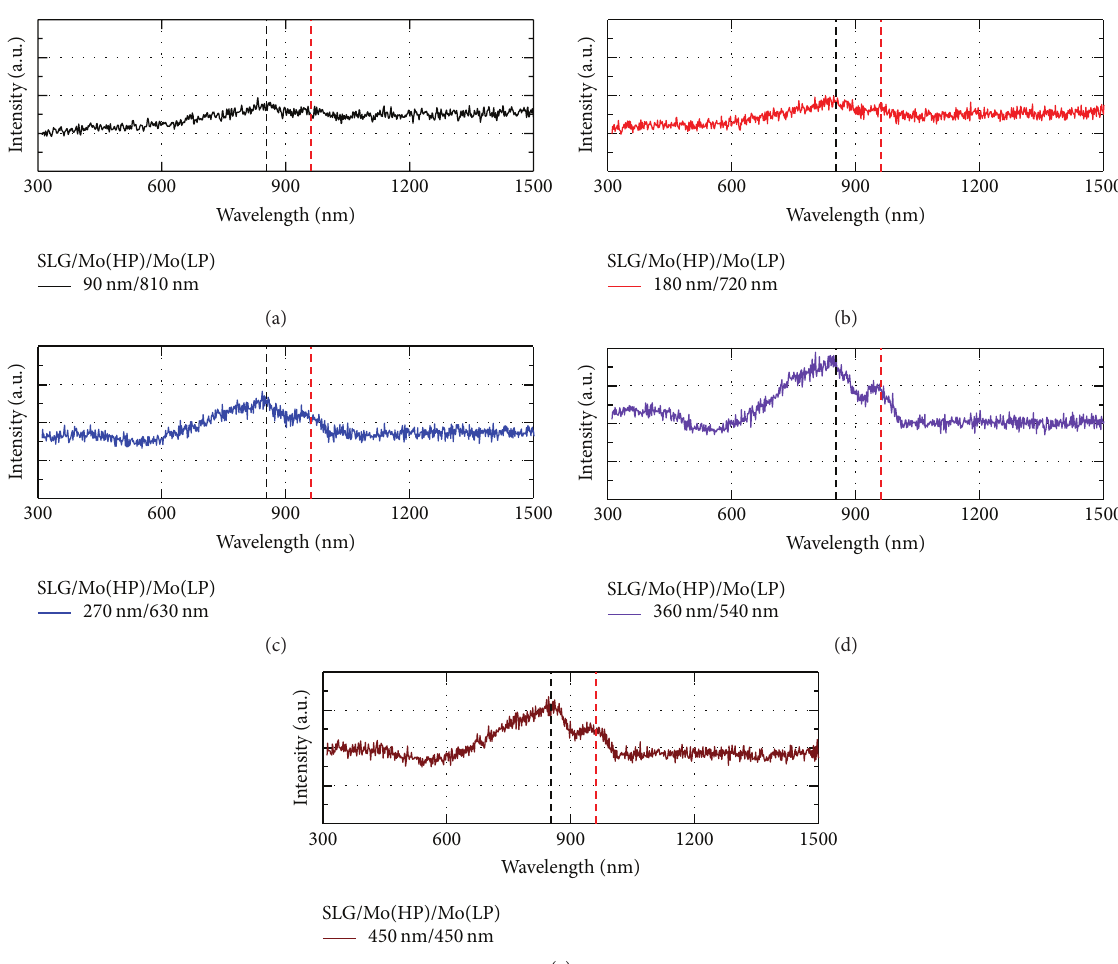
Figure 8: Raman spectra of bilayer Mo films with different thickness ratios of bottom layer and top